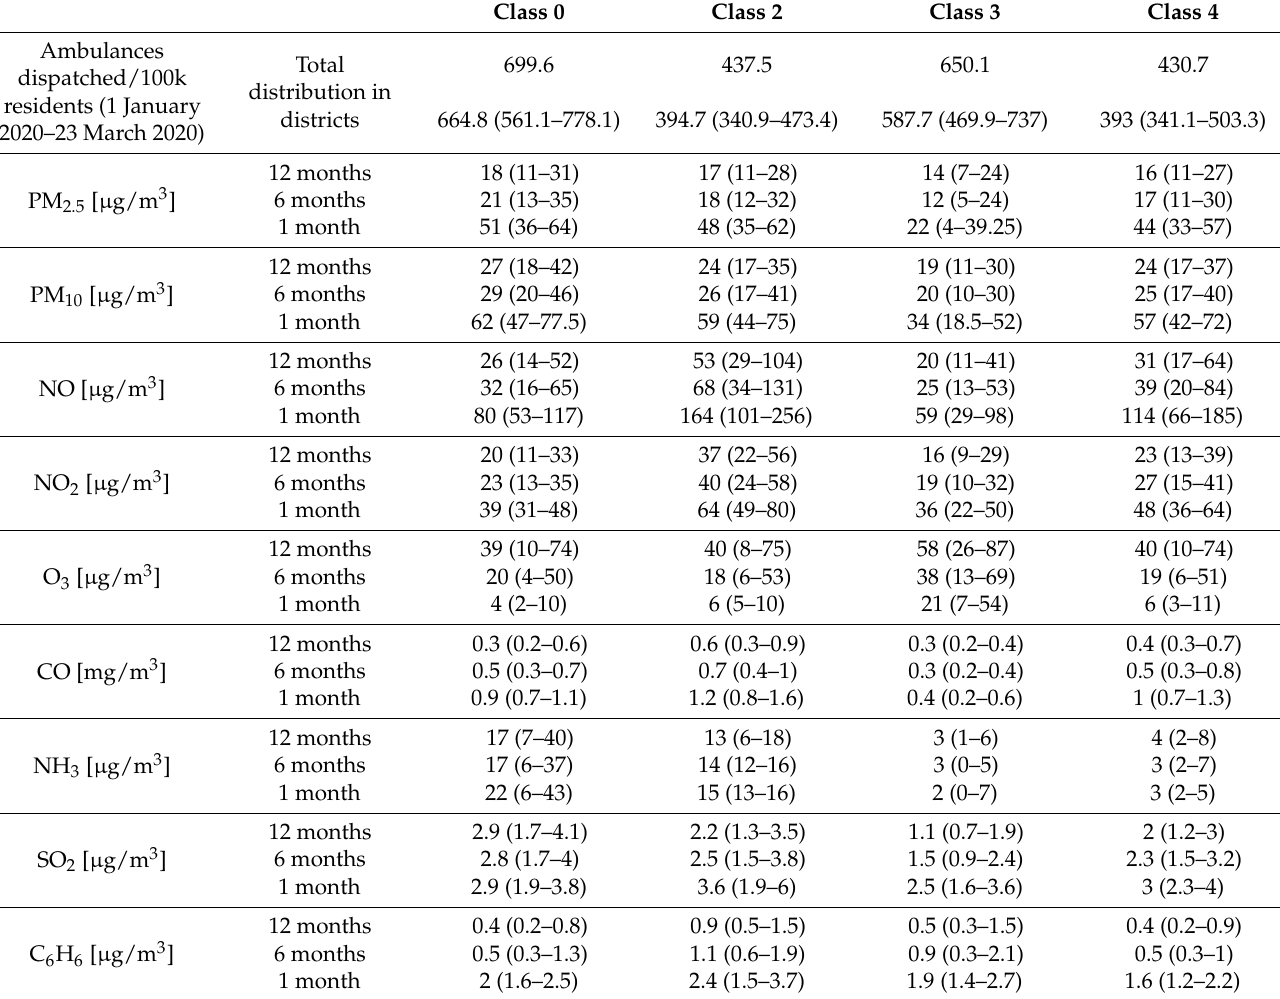
Table 2. Aggregated data distribution, expressed as median (25th–75th percentiles), for the four clustering classes TC (see text for details), reporting the cumulated prevalence of ambulances dispatched (normalized by 100,000 residents) in the considered time period (1 January 2020–23 March 2020), and the values distribution generated by the different districts composing each clustering class, together with the values distribution of all the measurements for each pollutant in the three considered time windows (12 months, 6 months, 1